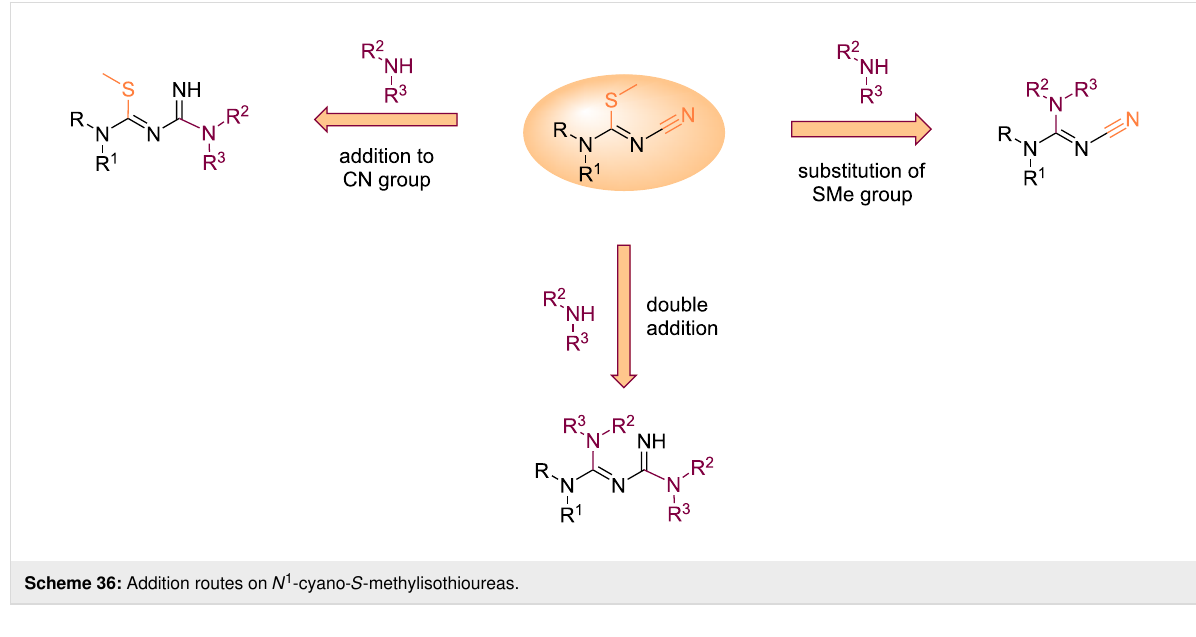
Table 2: Synthesis of biguanides by Lewis acid activation of N 1 -cyano- S -methylisothioureas [45].